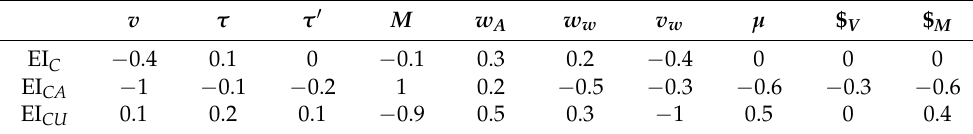
Table 6. The objective function elasticity